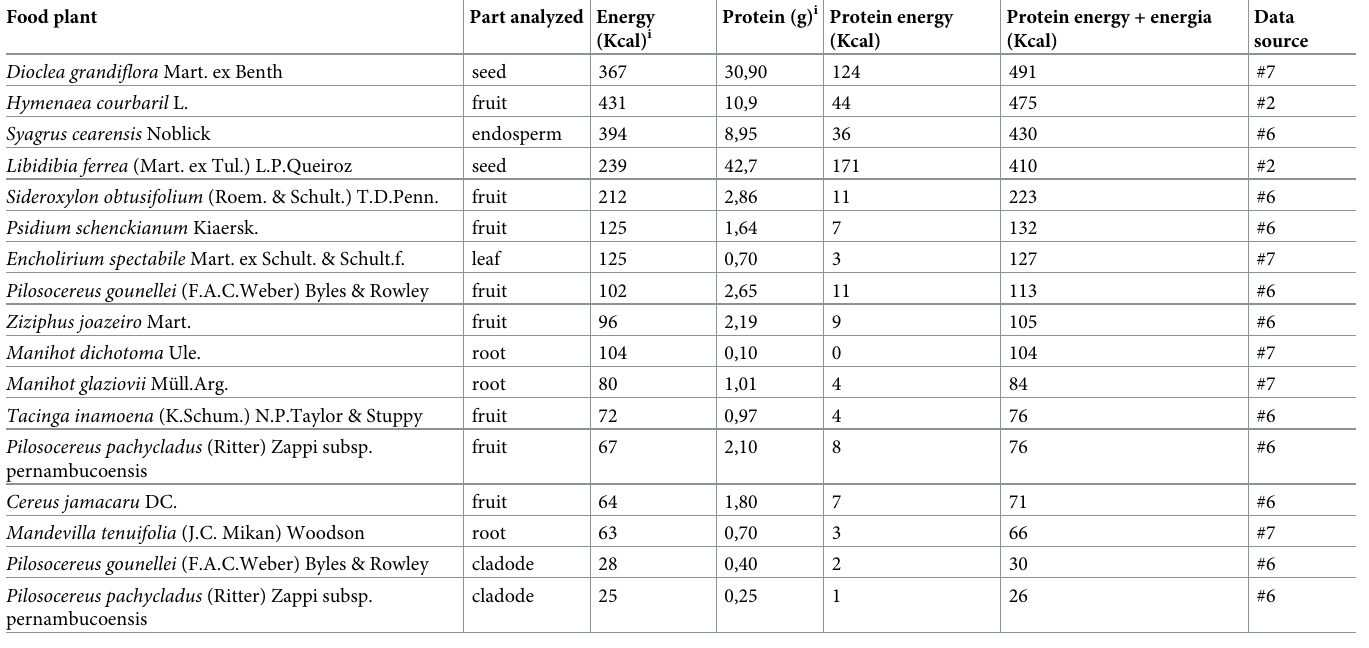
Table 3. Nutritional data of strategic food plants to promote food and nutrition security in the Caatinga. Food plant